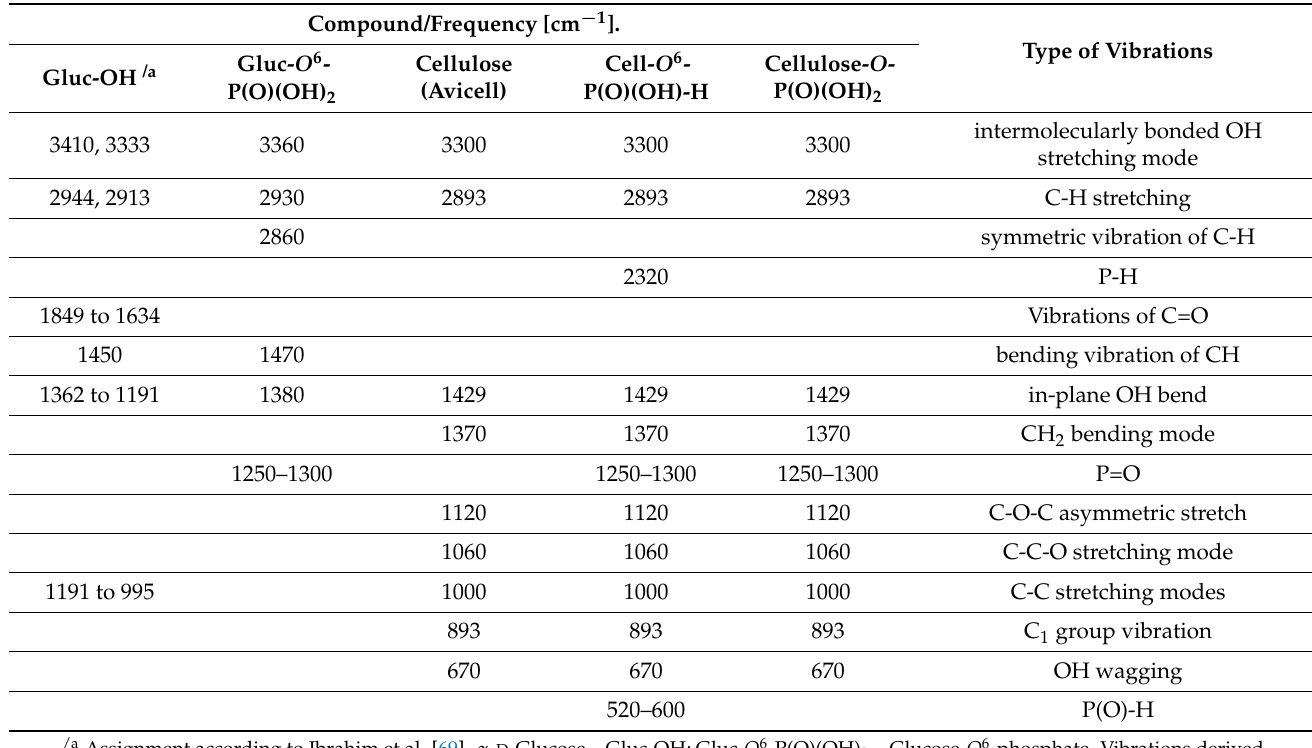
Table 6. Characterization of FTIR spectra of glucose, cellulose, glucose-phosphate, and cellulose-phosphates. Compound/Frequency [cm − 1